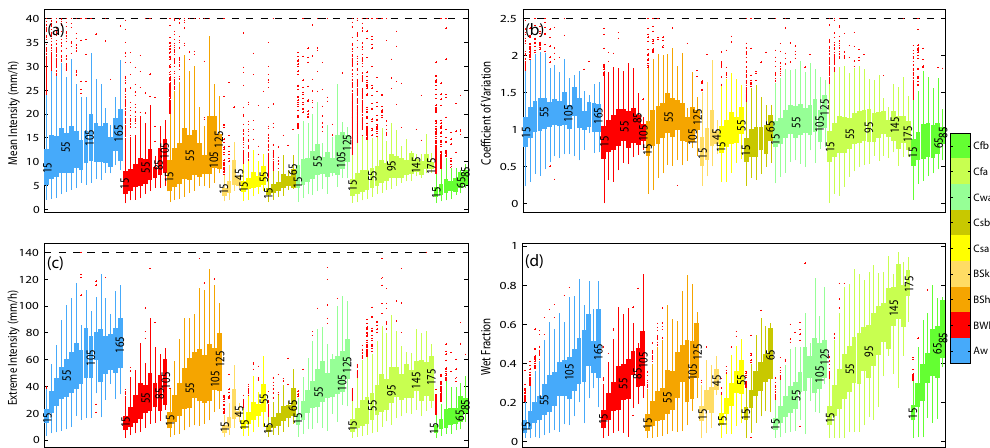
Fig. 10. Box plots showing variation in daily mean wet period intensity, daily wet period intensity, coefficient of variation, extreme intensity I HI , and wet fraction with daily rainfall accumulation for various K¨oppen climate zones. Daily rainfall has been categorised into 10mm bins with a lower limit of 10mm i.e. bin 1 includes daily rainfalls of 10–20mm. Only some bins are labelled to maintain clarity and labels represent the middle of the bin range. Note, boxes are only drawn where at least 10 days fall in the observation bins, bins are missing for the second highest accumulation amount in some cases and some observations exist above the maximum plotted box due to